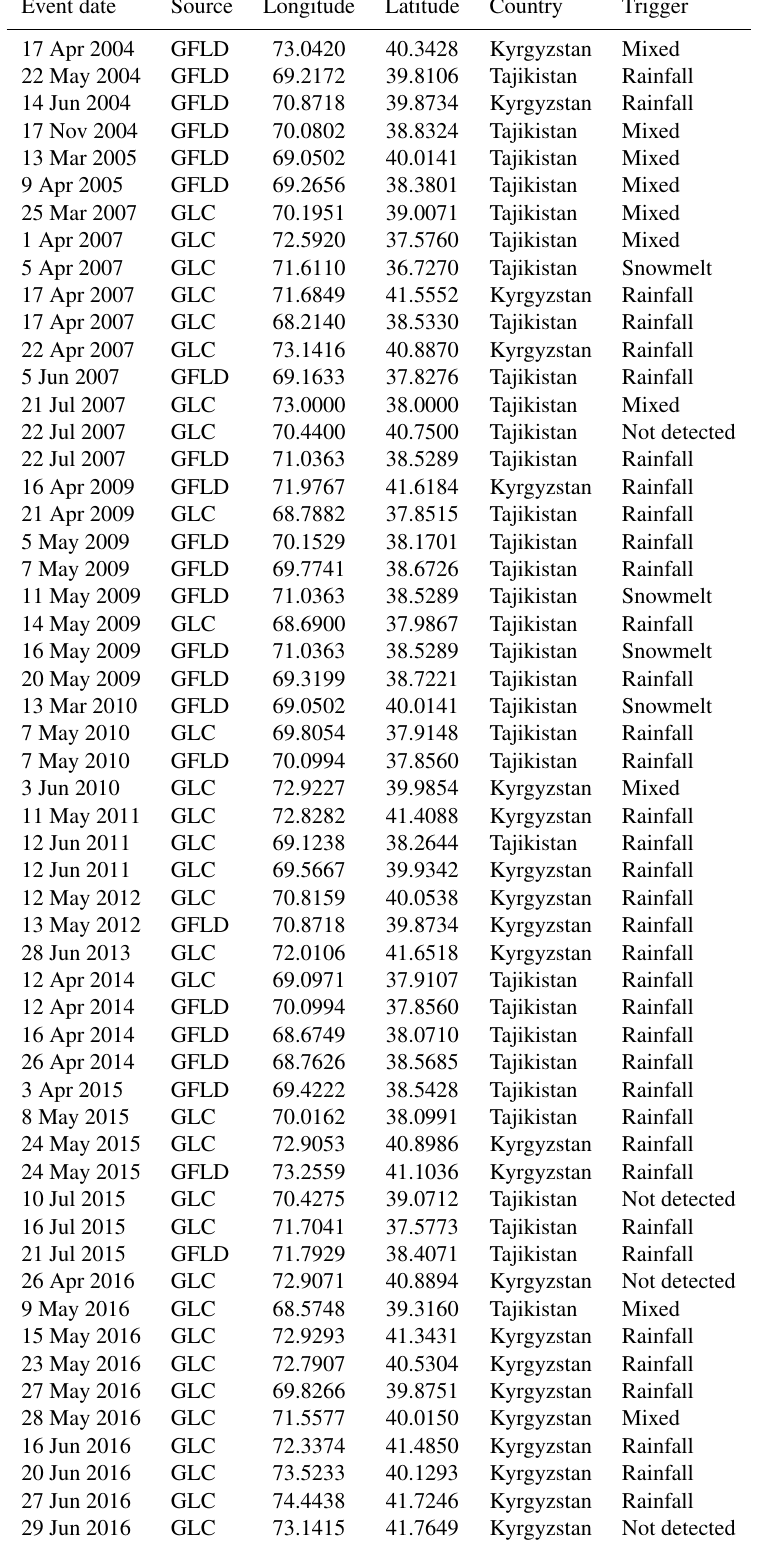
Table A1. Landslide events in Kyrgyzstan and Tajikistan extracted from the GLC and the GFLD from 2004 to 2018. The column “trigger” indicates the trigger of landslide events detected by the HAR